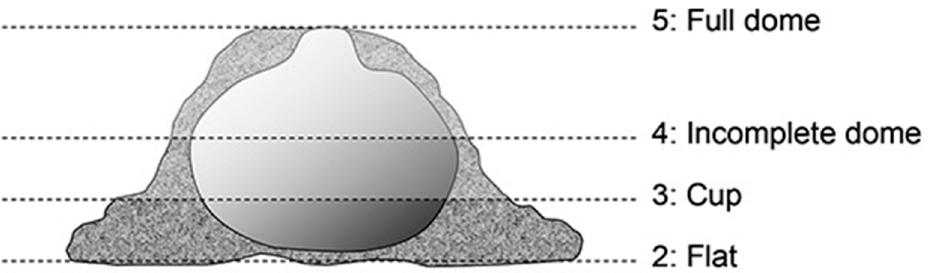
Figure 1. Scores characterizing nest quality.